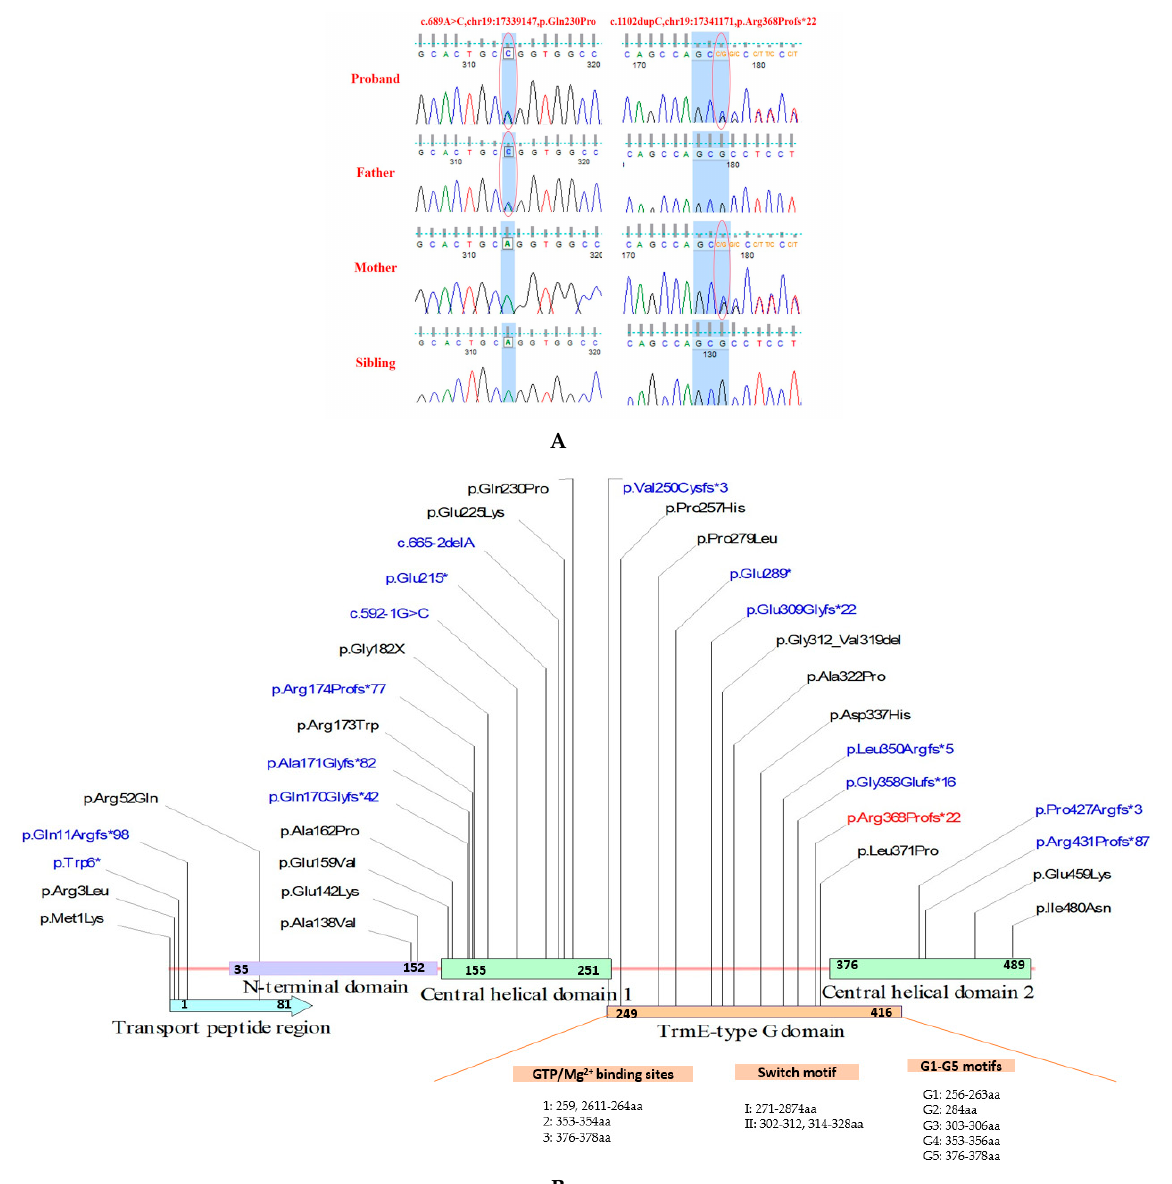
Figure 2. The pedigree and identified GTPBP3 variants. ( A ) The variant c.689A>C (p.Gln230Pro) was detected in the proband and his father, and variant c.1102dupC (p.Arg368Profs*22) was detected in the proband and his mother. Both variants were shown in the red circle. ( B ) Distribution of 35 GTPBP3 variants in clinical samples across the GTPBP3 protein domains. The GTPBP3 protein domains include the transport peptide region (light blue region), the N-terminal domain (light purple region), central helical domain 1 (light green region), the TrmE-type GTP-binding domain (orange region), and central helical domain 2 (C-terminal domain, light green region). The novel variants identified in this study are highlighted in red, loss-of-function variants in blue, and missense variants in